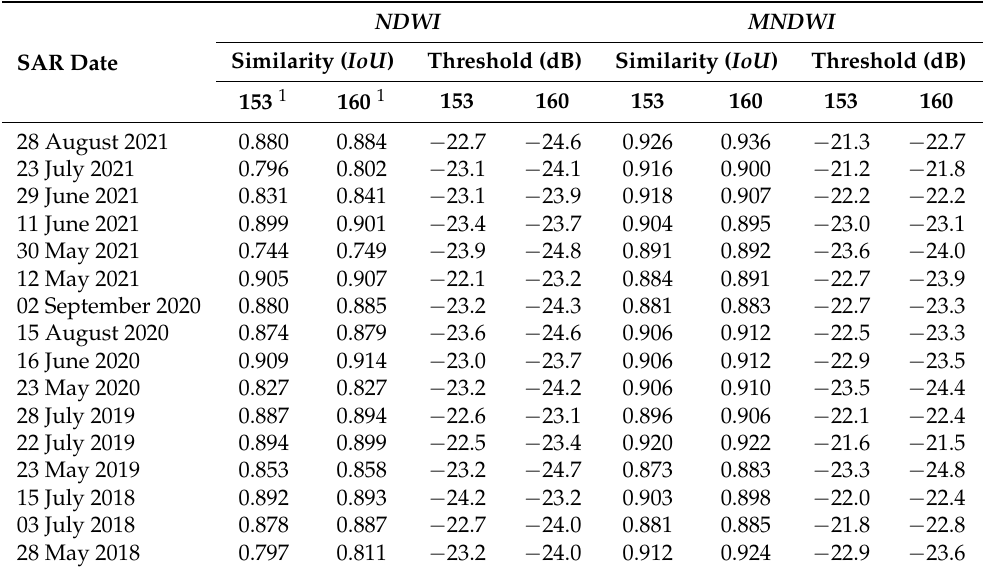
Table 5. σ 0 threshold values and IoU metrics of SAR and optical water masks similarity for VH path = 160, path = 153, and all observation